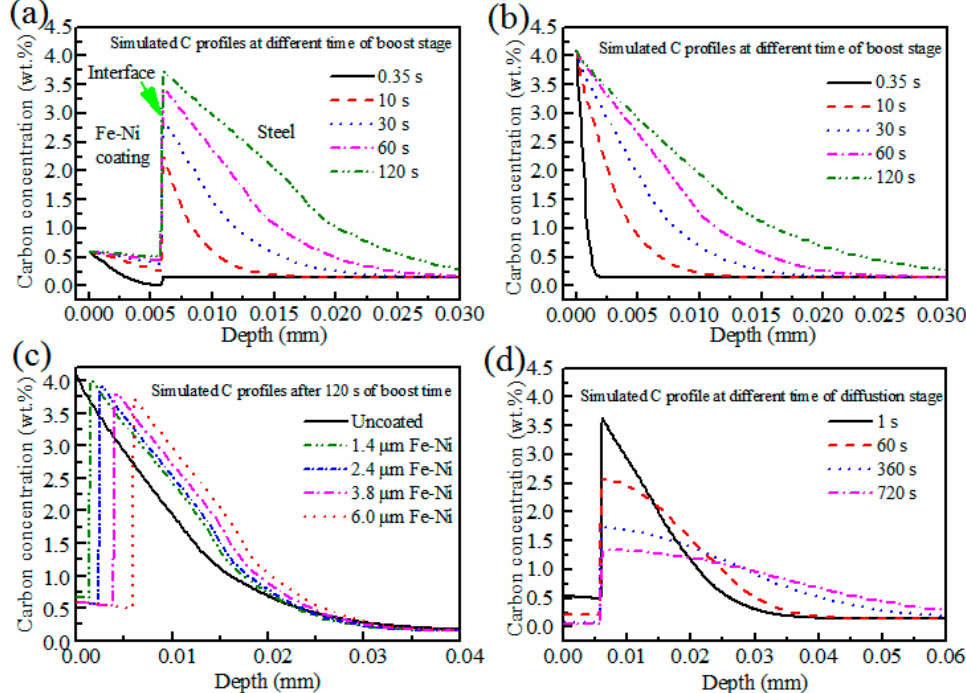
Figure 8. Simulated carbon profiles at temperature of 890 °C: ( a ) uncoated sample at different times during the boost stage, ( b ) sample coated with 6.0 μ m Fe–Ni film at different times during the boost stage, ( c ) carbon profiles at the end of first boost stage, and ( d ) sample coated with 6.0 μ m Fe–Ni film at different times during the diffusion stage.